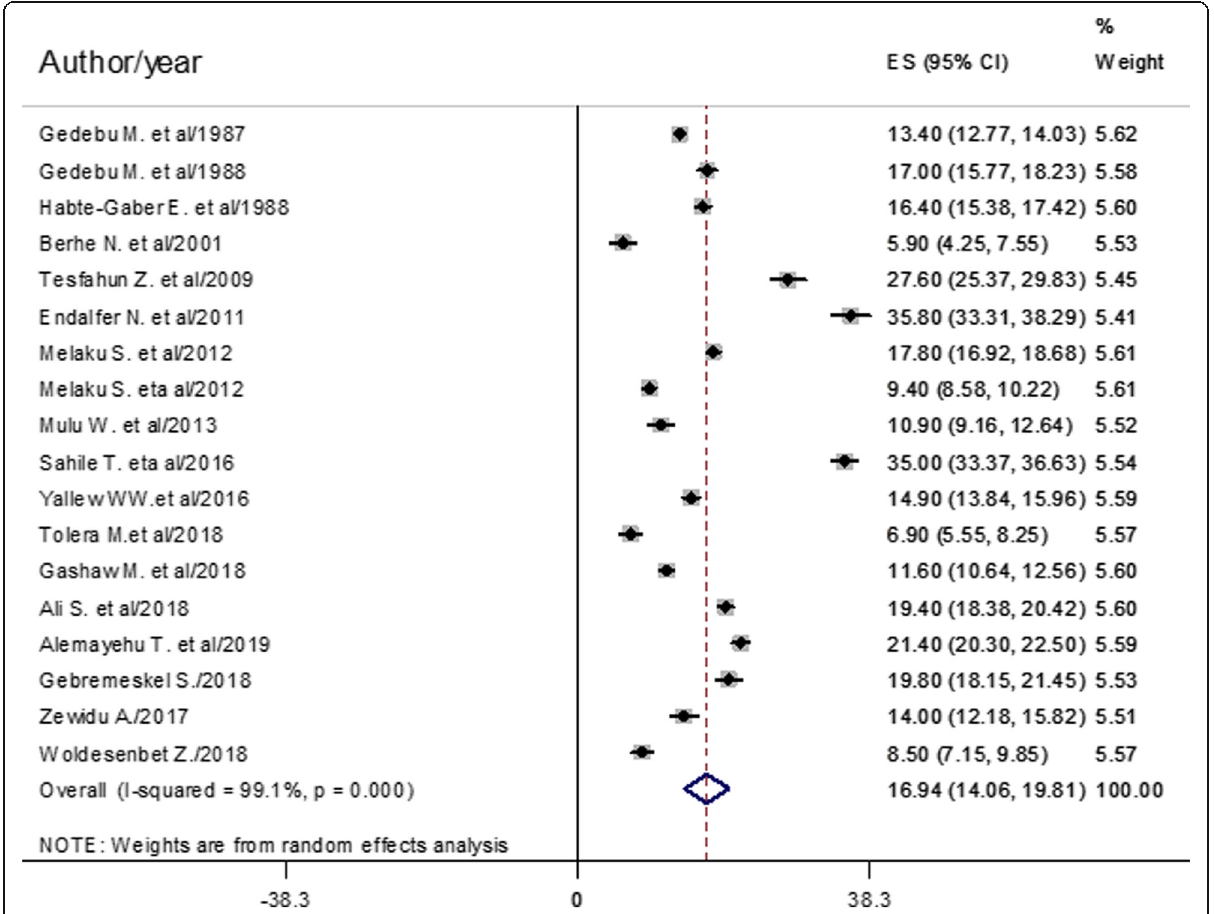
Fig. 2 Forest plot of the overall pooled prevalence with corresponding 95% CIs of eighteen studies on